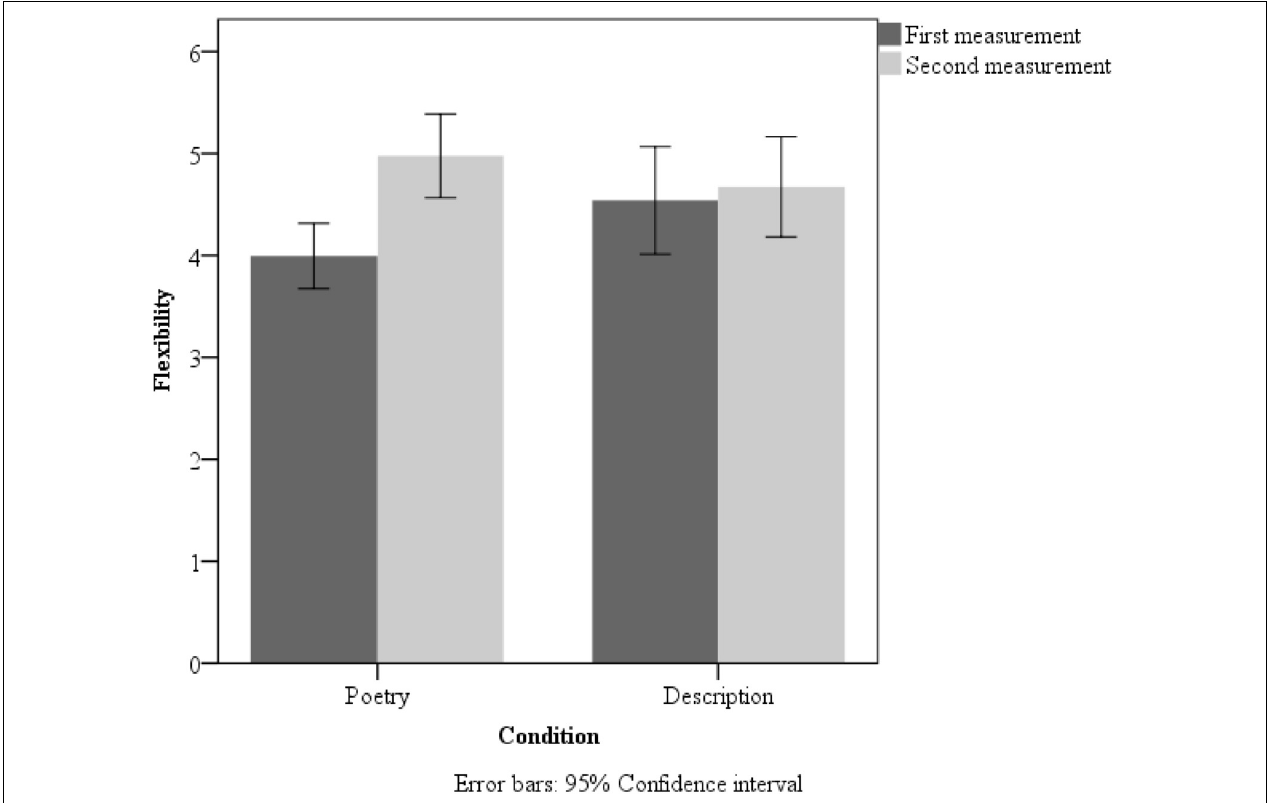
FIGURE 2 | Mean flexibility scores in the poetry-reading group and description-reading group in the first and second measurement in Study 1. Error bars: 95% Confidence